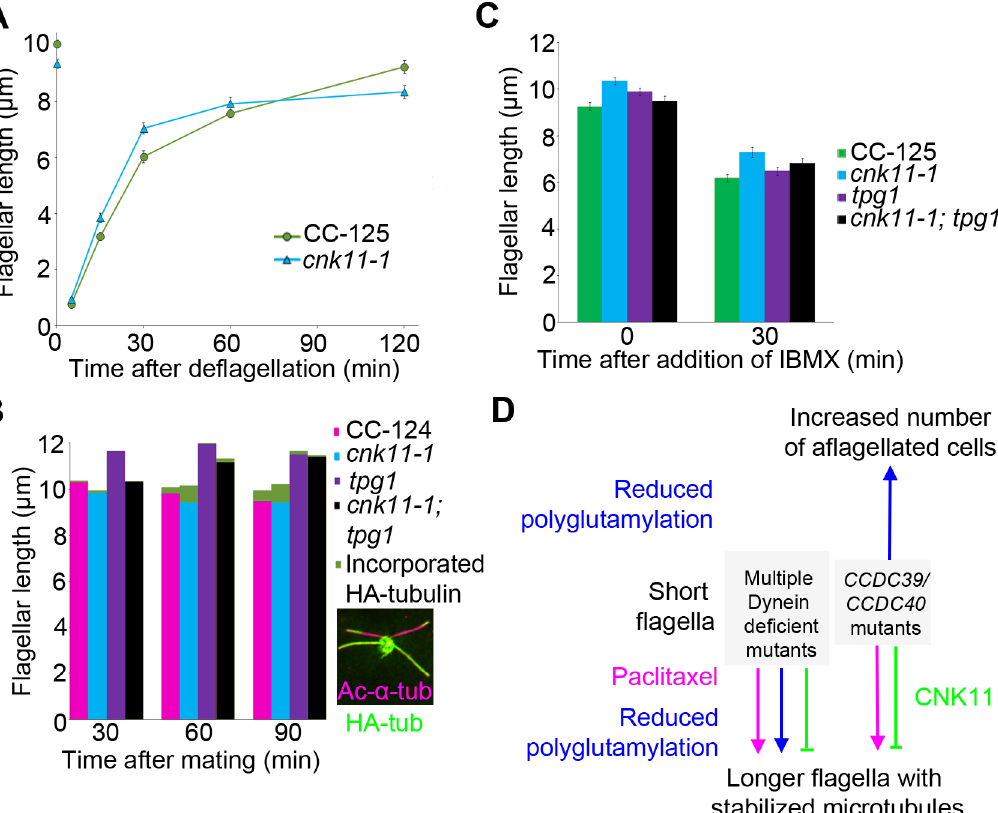
Fig 8. The cnk11-1 mutant has increased tubulin turnover at the flagellar tip. At least 100 flagella from each strain were measured to determine the average flagellar length. Error bars represent standard deviation of the mean. (A) Flagellar lengths of wild-type (CC-125, green circles) and cnk11-1 (blue triangles) cells before and after deflagellation by pH shock. (B) Cells that carry HA- α -tubulin were mated to cells of opposite mating type that have the corresponding genotype for 30, 60, and 90 minutes before fixation. Flagellar lengths were measured from the non HA-tagged parental strain in mating of wild-